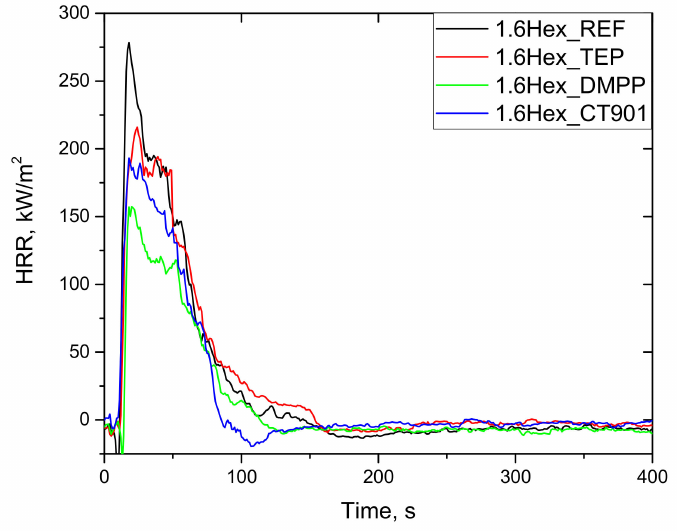
Figure 12. HRR curves (CONE) of rigid polyurethane foams with 40 wt.% bio-polyol. Interpretation of the data obtained after the cone calorimeter test can be performed using the MARHE value, which determines the risk of fire development [44]. All flame retar- dants in both systems reduced MARHE value, and the lowest value among the tested foams was for the P_DMPP foam and 1.6Hex_DMPP foam equaled 97 kW/m 2 and 99 kW/m 2 , respectively, which is a reduction of 29% and 37% compared to their reference